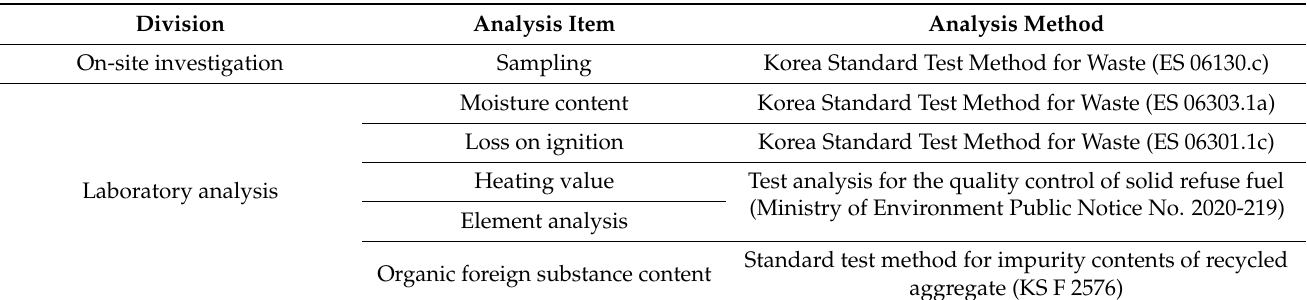
Table 2. Analysis methods for SRF